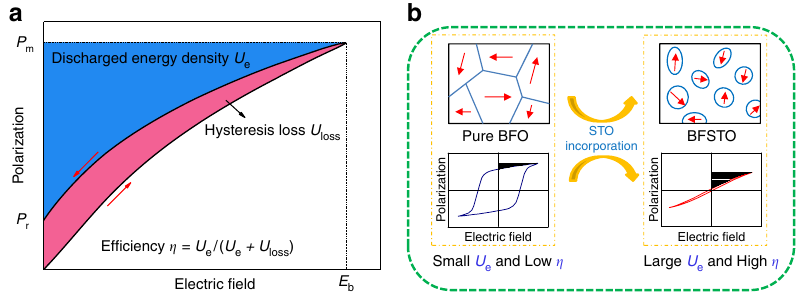
Fig. 1 Schematic illustrations. a A typical P – E loop of a dielectric and an illustration of (discharged) energy density U e , hysteresis loss U loss and ef fi ciency η . The red arrows indicate the charging and discharging processes. b Schematic of domain evolution and FE-to-RFE transition induced by the incorporation of STO into BFO, leading to concurrently improved U e and η . The blue outlines indicate the ferroelectric domains and the red arrows denote the spontaneous polarization